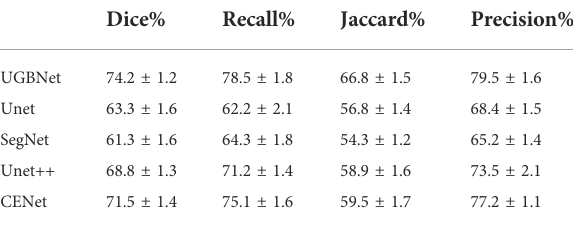
TABLE 1 Quantitative evaluation of different methods for spinal ultrasound image